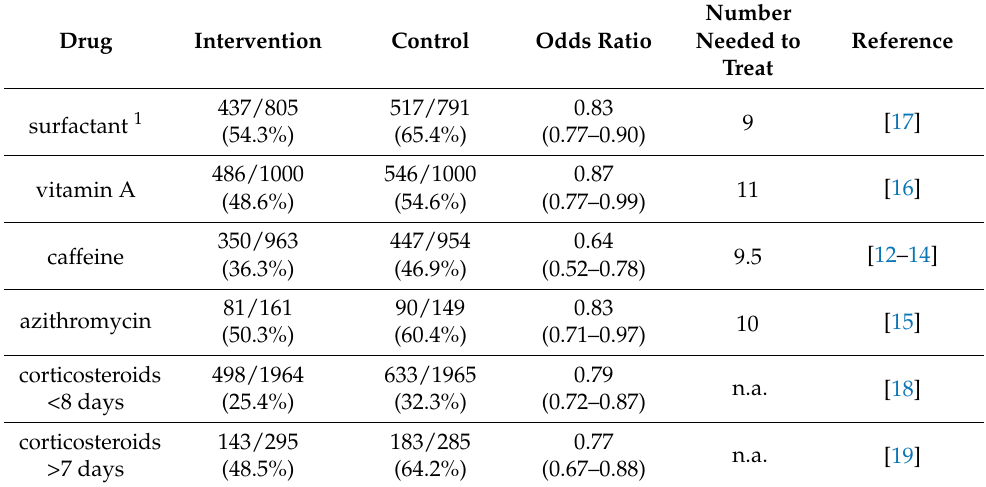
Table 1. Drugs with proven therapeutic efficacy to prevent bronchopulmonary dysplasia